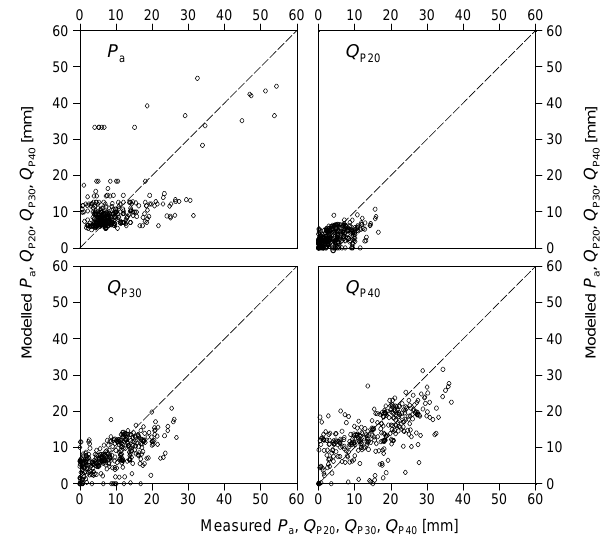
Fig. 5. Modelled vs. measured initial abstraction P a , and accumu- lated runoff after 20, 30 and 40mm of rainfall ( Q P 20 , Q P 30 and Q P 40 ,respectively) ; data shown combine all validation results of the ten-fold cross validation; root mean square errors are 7.0, 3.5, 5.3, and 6.9 for P a , Q P 20 , Q P 30 , and Q P 40 ,